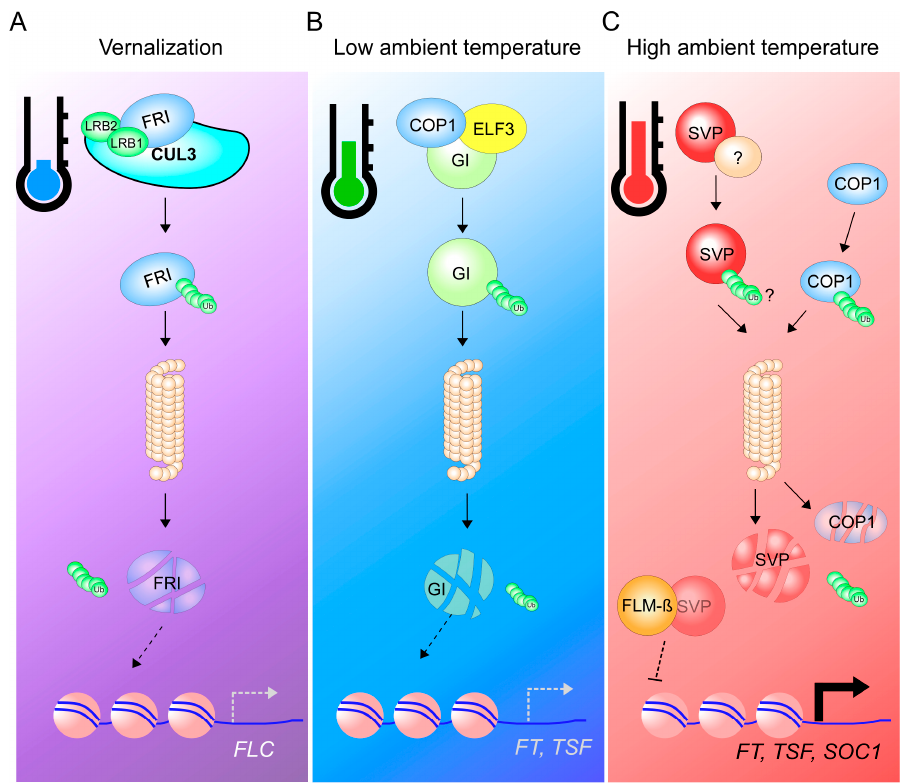
Figure 3. Temperature-dependent degradation of flowering time regulator proteins by the 26S proteasome. ( A ) Degradation of FRIGIDA (FRI) protein by the 26S proteasome. LRB1 and LRB2, members of the BTB protein family, along with CUL3A ubiquitin-E3 ligase polyubiquitinate FRI proteins under cold treatment (vernalization). The poly-Ub-tagged FRI proteins are then degraded by the 26S proteasome pathway, resulting in insufficient quantities of FRI proteins, which fail to repress FLC expression. This contributes to the vernalization-dependent repression of FLC in winter annuals, thereby accelerating flowering. ( B ) Low ambient temperature-induced degradation of GIGANTEA (GI) by the 26S proteasome. At low ambient temperatures, COP1, an ubiquitin-E3 ligase, along with ELF3 regulates levels of GI protein, which is an activator of flowering, through the 26S proteasome pathway. As a result, FT expression is reduced and flowering is delayed. ( C ) High ambient temperatures result in the degradation of SVP protein. Unknown ubiquitin ligase enzymes ubiquitinate SVP. This leads to reduction in the levels of the FLM- β -SVP repressive protein complex, thereby de-repressing the expression of floral activator genes ( FT , TSF , and SOC1 ). Also, at high ambient temperatures, COP1 protein is unstable. These complex temperature-responsive systems ensure plants’ successful reproduction under fluctuating temperature conditions. Faint oval and fragmented ovals indicate proteins with low abundance and degraded protein, respectively. Arrows and dashed arrows denote activation and inability to activate, respectively. A dashed T-bar indicates a failure of suppression of transcription of target genes.